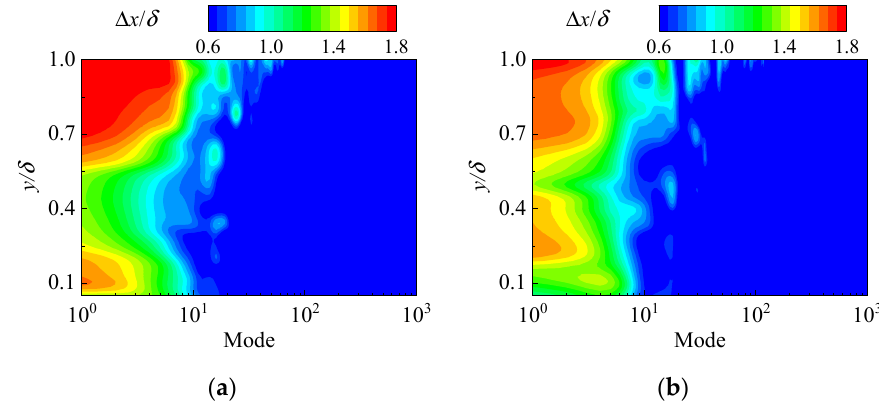
Figure 5. The spatial scale in flow direction: ( a ) None; ( b ) Control.